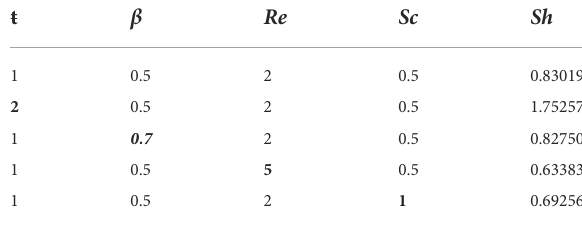
The bold-italic values shows the increasing values of the